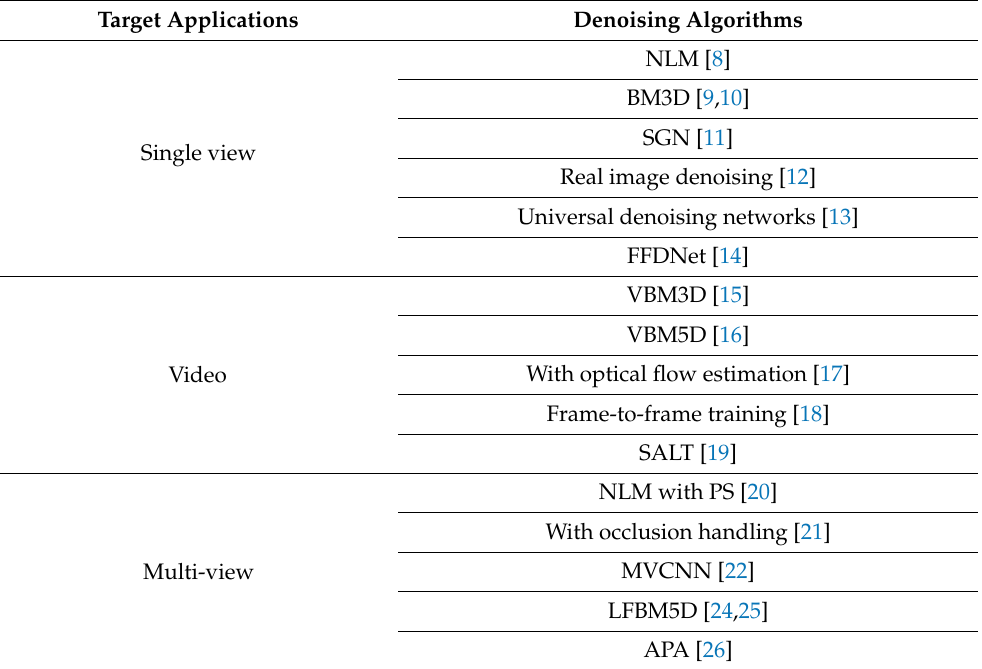
Table 1. Previous works of denoising